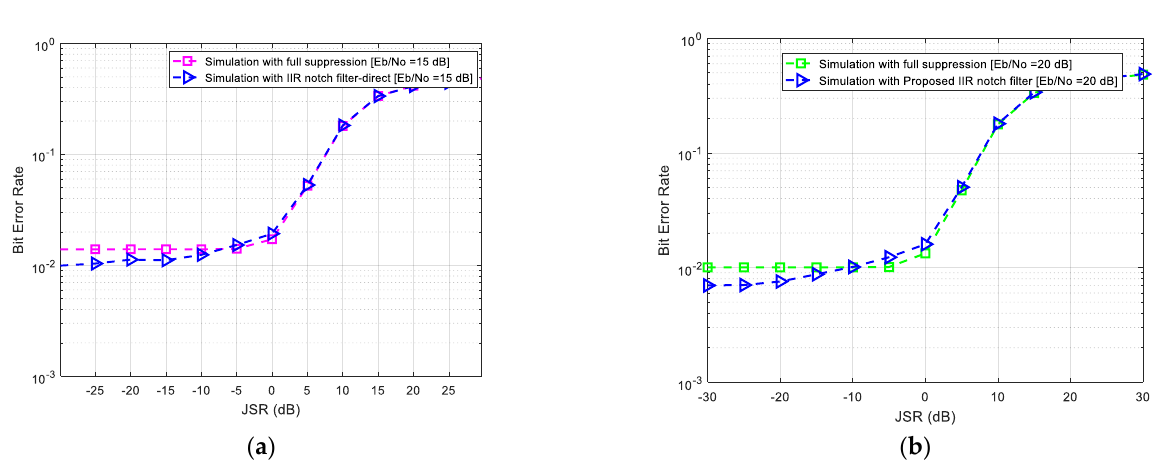
Figure 16. BER vs. JSR (using an S-ANF; full suppression means k 1 = 1): ( a ) E b / N o = 15 dB, and ( b ) E b / N o = 20 dB.